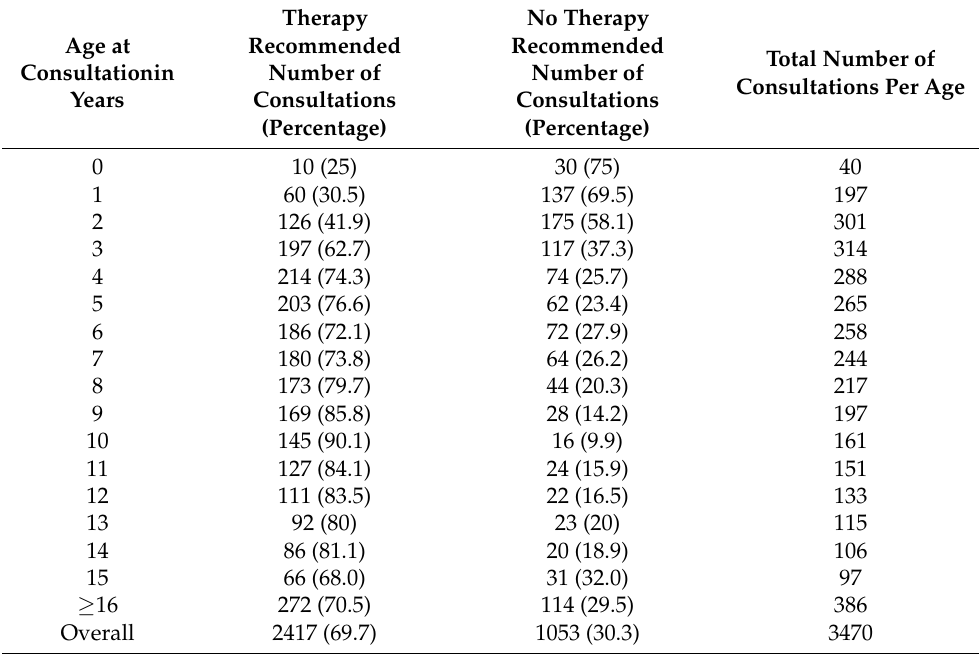
Table 1. Number of consultations in which one or more therapy recommendations were given, broken down by age in